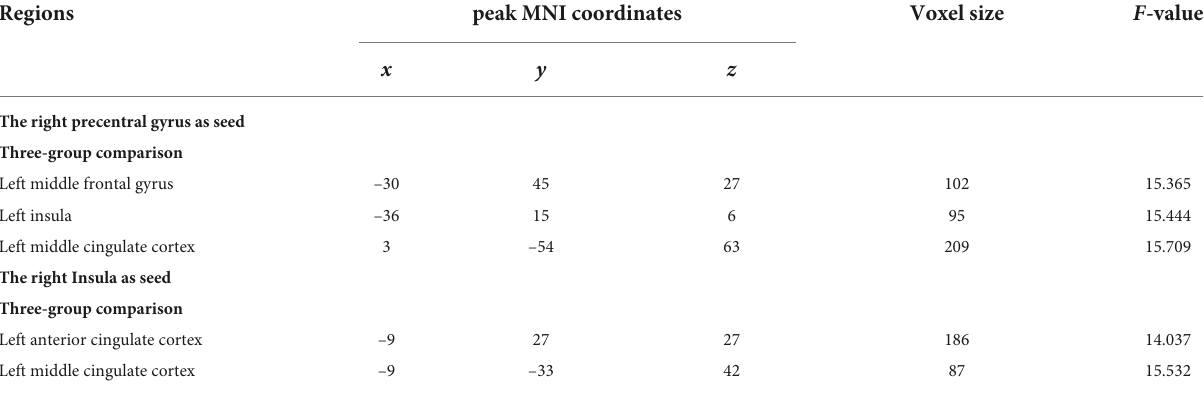
TABLE 3 Significant differences in mean FC among SA, non-SA, and HC groups. Regions peak MNI